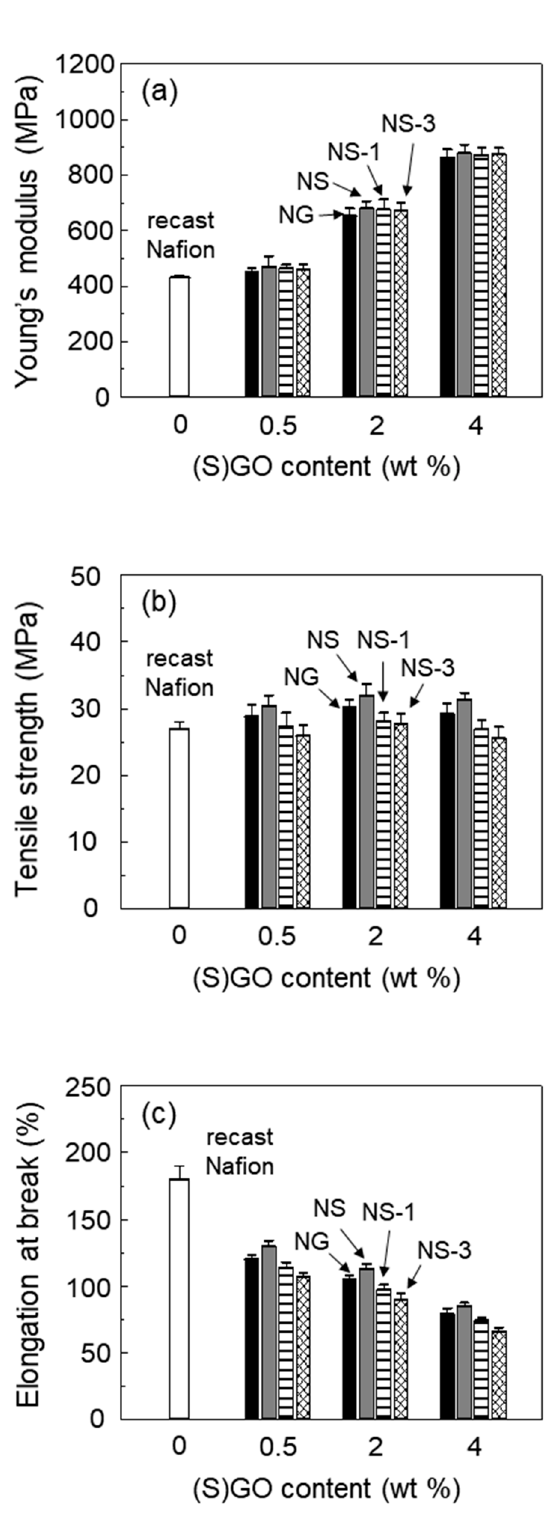
Figure 3. ( a ) Young’s modulus, ( b ) tensile strength and ( c ) elongation at break of recast Nafion and its composites with GO, SGO, and SGO/ceria in varying filler